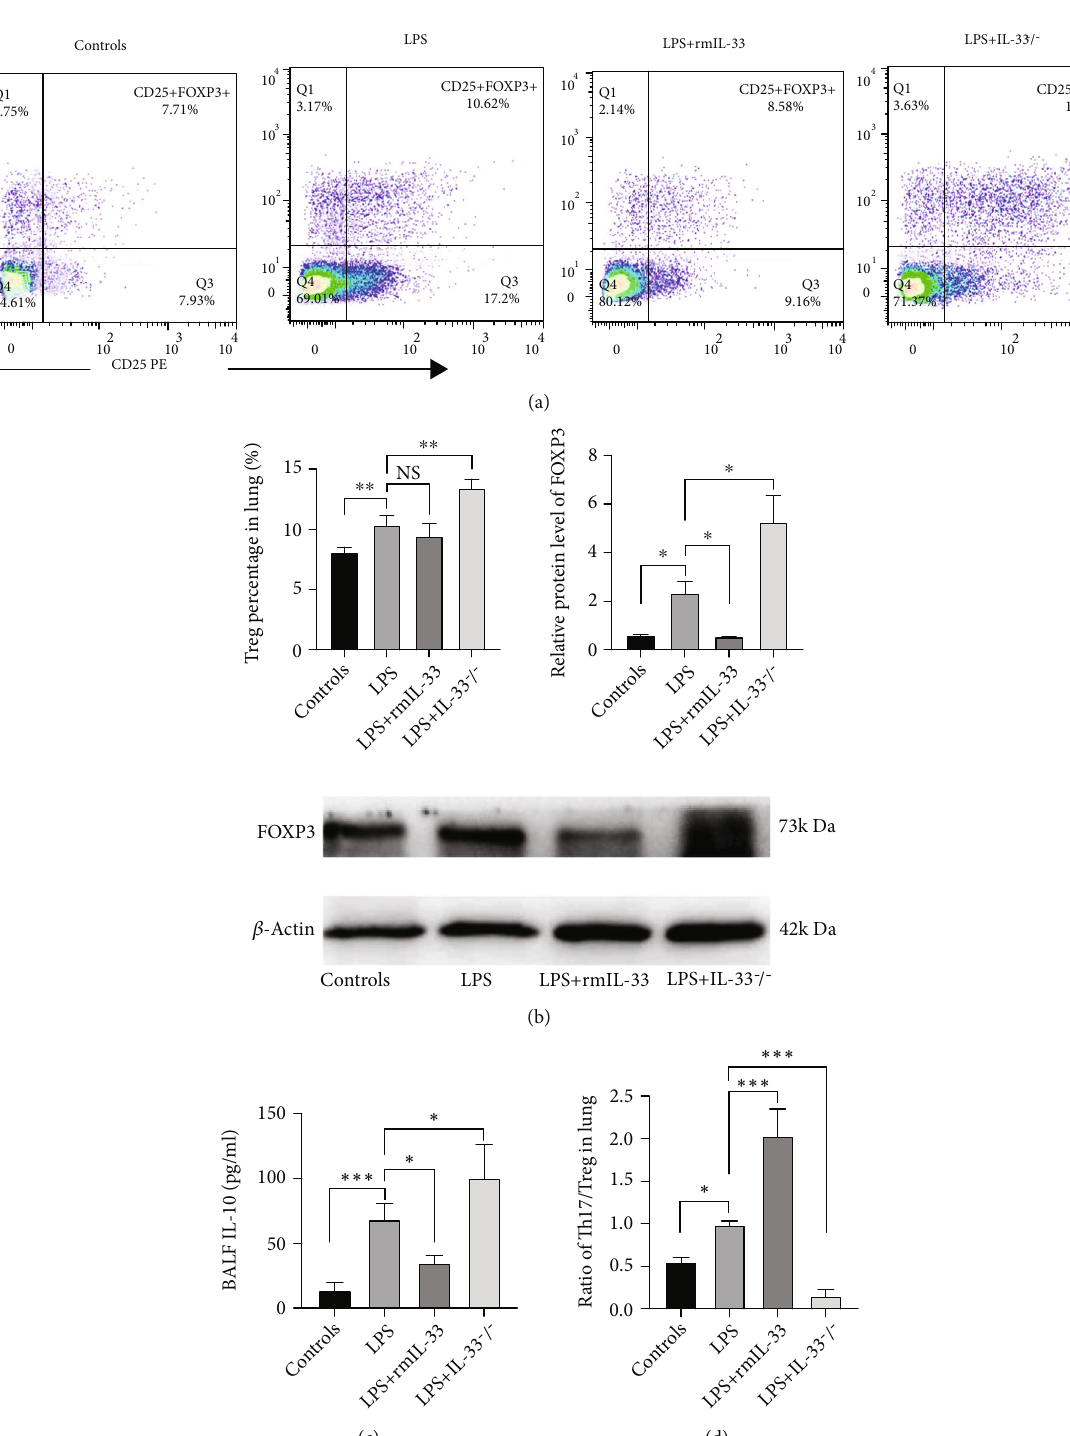
Figure 5: IL-33 de fi ciency enhanced the Treg cell response in murine ARDS. (a) The percentage of FOXP3+CD25+CD4+ T cells in the lung was detected by fl ow cytometry. (b) FOXP3 protein expression in lung tissue was measured by Western blotting. (c) The concentrations of IL-10 in BALF were detected by ELISA. (d) The ratio of Th17/Treg cells in the lung. The data are expressed as the means ± SDs . Signi fi cant di ff erences are shown by ∗ P < 0 : 05 , ∗∗ P < 0 : 01 , and ∗∗∗ P < 0 : 001 by one-way ANOVA followed by Bonferroni ’ s post hoc test comparing the WT control, LPS, LPS+rmIL-33, and LPS+IL-33 -/- groups. N = 3 ‐ 5 for each group, and three independent repeated experiments were carried